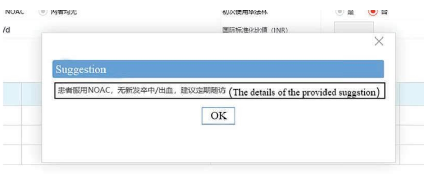
Figure 4: Examples of treatment suggestions during follow-up